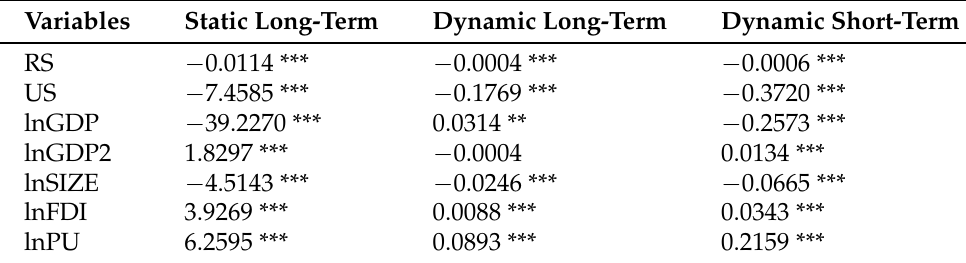
Table 12. Spatial spillover